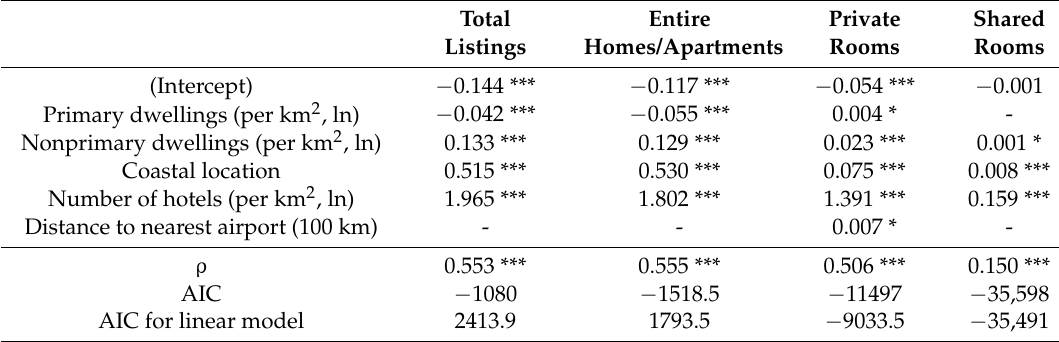
Table 6. Final spatial lag models for municipalities (N =